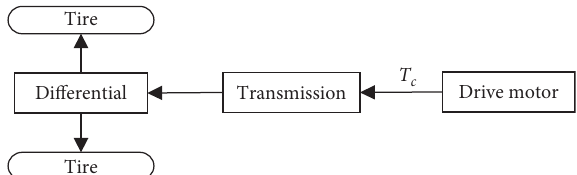
Figure 3: Schematic diagram of the vehicle powertrain